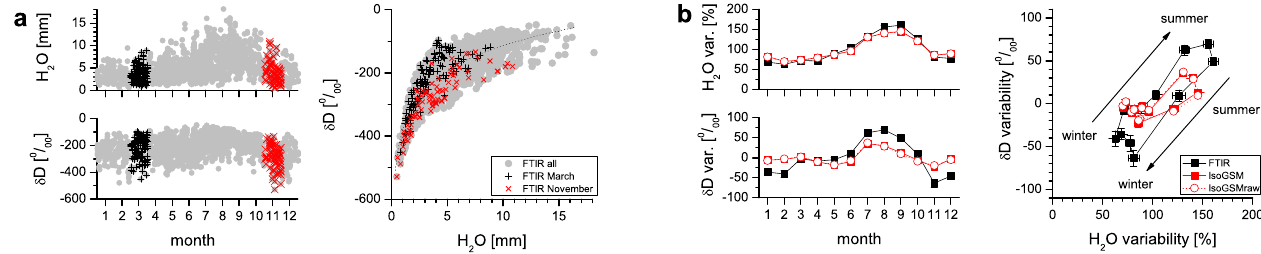
Fig. 15. Multi-year annual cycles of column-integrated H 2 O and δ D as observed by the ground-based FTIR system at Iza˜na. Panel a: all observations (all March and all November observations are highlighted by black and red crosses, respectively); Panel b: Intra-annual variability of monthly averages (black: FTIR observations, red solid squares: IsoGSM simulations smoothed by FTIR kernels, red circles: unsmoothed IsoGSM simulations.)